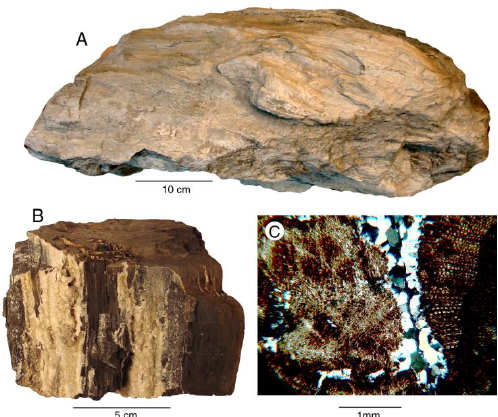
Figure 3. Dolomite wood from Eocene Puget Group, King County, Washington, USA. ( A ) Log from John Henry Coal Mine, Black Diamond, Washington; ( B ) dolomitized wood fragment showing megascopic crystalline quartz (light colored) deposited in fractures. From coal-bearing beds near Issaquah, Washington; ( C ) Thin section of Issaquah wood, composed of dolomitized tissue with microcrystalline quartz filling fractures.